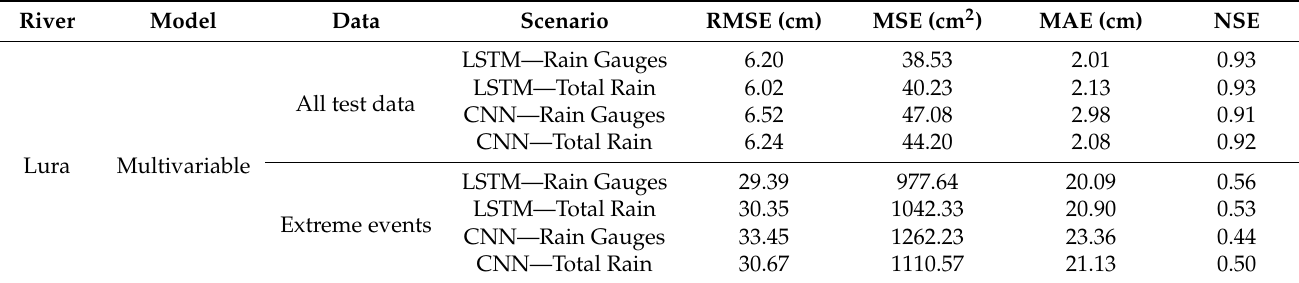
Table 6. Performance of multivariable models for the Lura River: average value of evaluation metrics over the forecasting horizon ( h ) in the entire test dataset and flood events (rain gauges and total rain